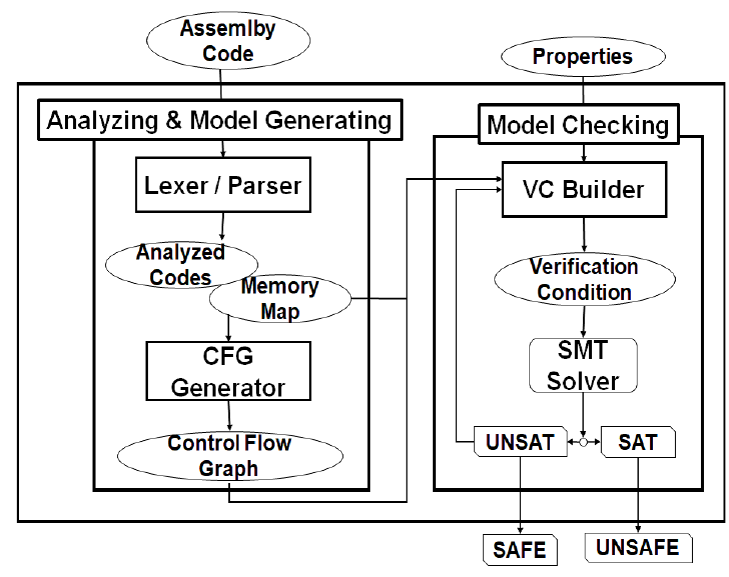
Figure 9. Configuration of prototype model